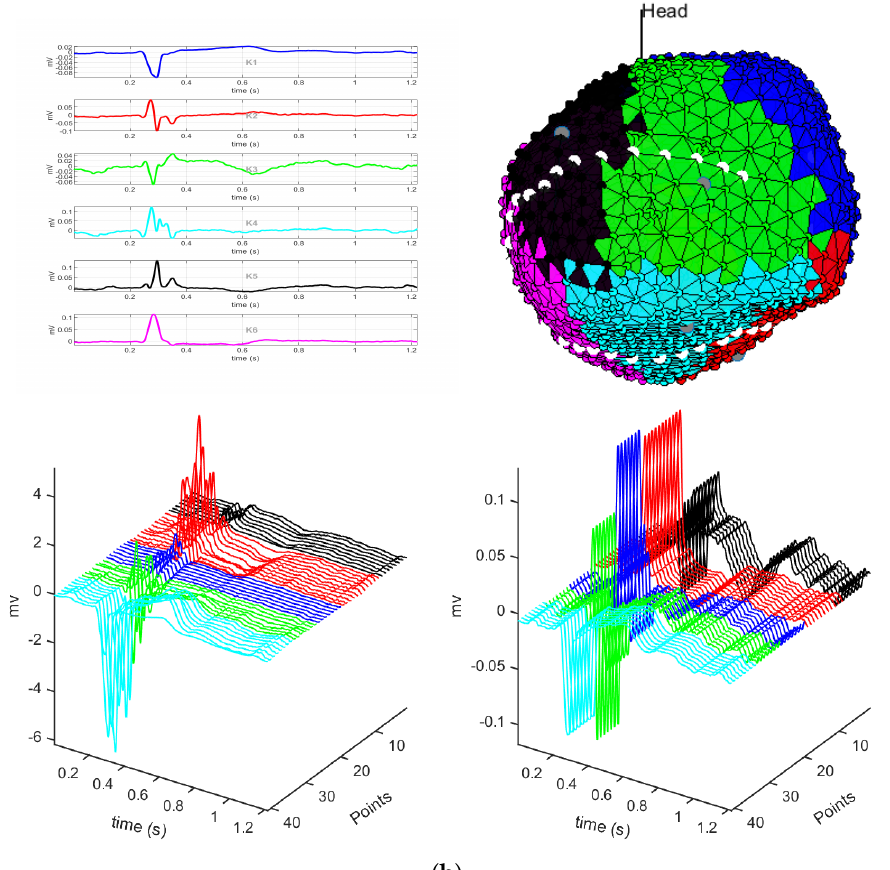
Figure 3. Unipolar EGM in the presence of infarction, using cosine distance with K = 5 ( a ) and with k = 6 ( b ). Continued from Figure